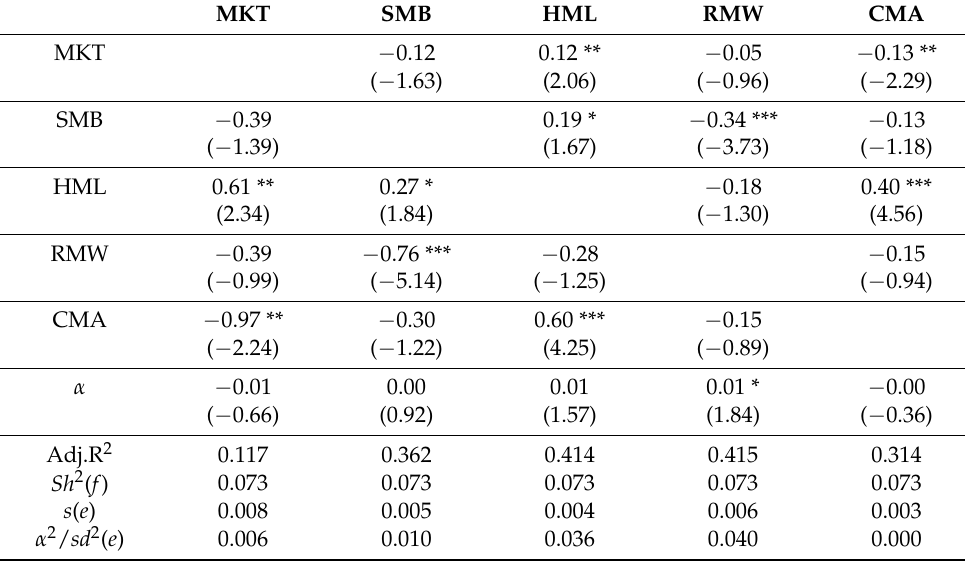
Table 6. Testing a Fama–French factor by regressing the remaining variables of the five-factor model. The table reports the results of time-series regressions with each of the variables being regressed by the remaining of the five factors. MKT is the value-weighted excess return on the market portfolio, and SMB is average return on the portfolio sorted by size. HML is the value factor with size and book-to-market sort. RMW is the profitability factor. CMA is the investment factor. All factors are 2 × 3 portfolios constructed using Fama and French’s (1993, 2015) methodology. Sh 2 ( f ) is the maximum squared Sharpe ratio for a model’s factors from Table 5. α , s ( e ) and α 2 / sd 2 ( e ) are the factor’s intercept, residual standard error from spanning regressions and the marginal contribution of a factor to a model’s Sh 2 ( f ), respectively. The Newey–West t -statistic is given in parentheses. The sample is from September 2008 to July